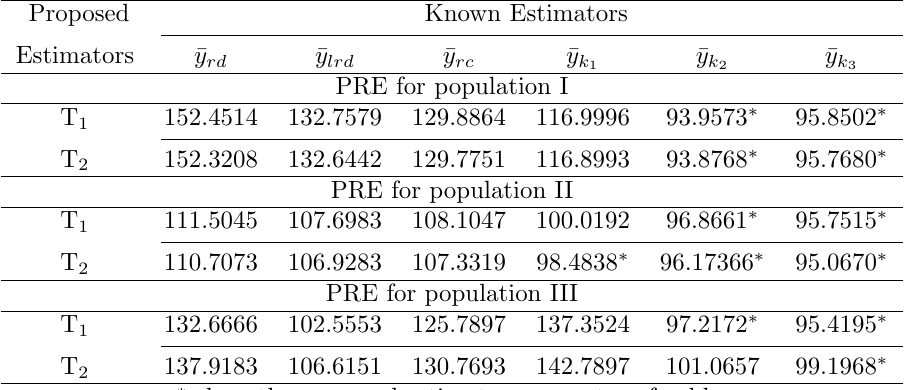
; (cid:22) y k and (cid:22) y k : 1 2 3